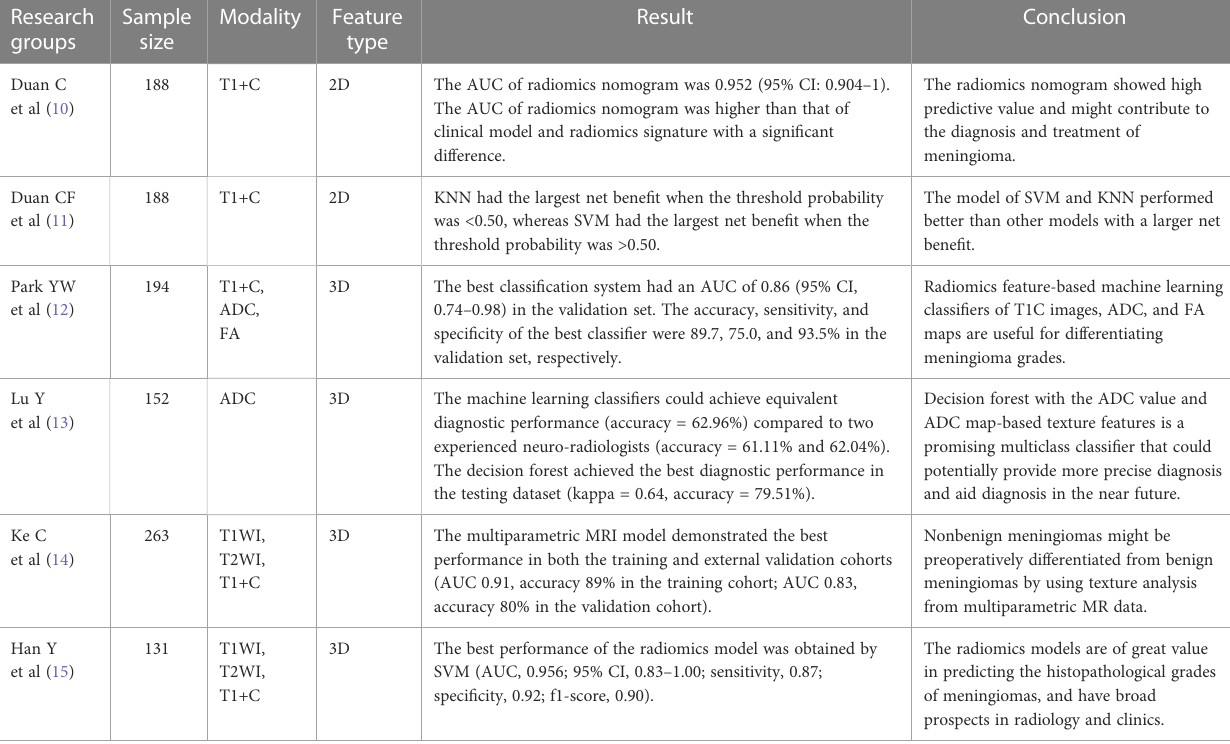
TABLE 1 Summary of previous studies of radiomics in predicting meningioma